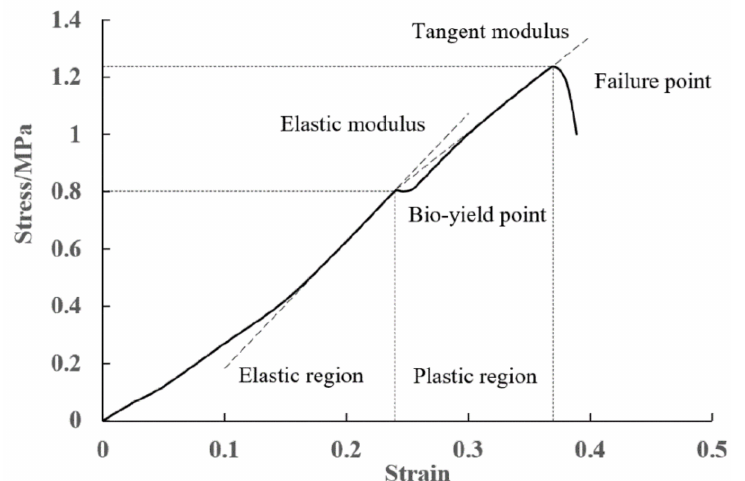
Figure 4. The stress–strain curve of carrot flesh.